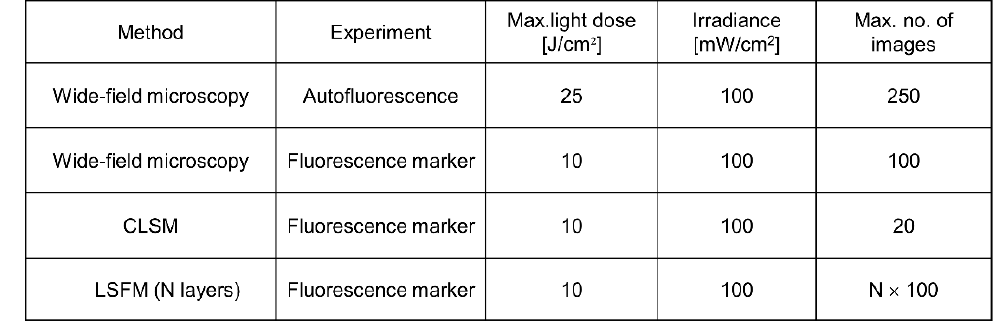
Figure 2. Maximum non-phototoxic light doses and maximum number of images for various methods of 3D live cell imaging. For autofluorescence experiments an excitation wavelength of 375 nm is assumed. An exposure time of 5 s is assumed for LSFM, and a time of 1 s for all other (wide-field) techniques (data partly reproduced from [8]).